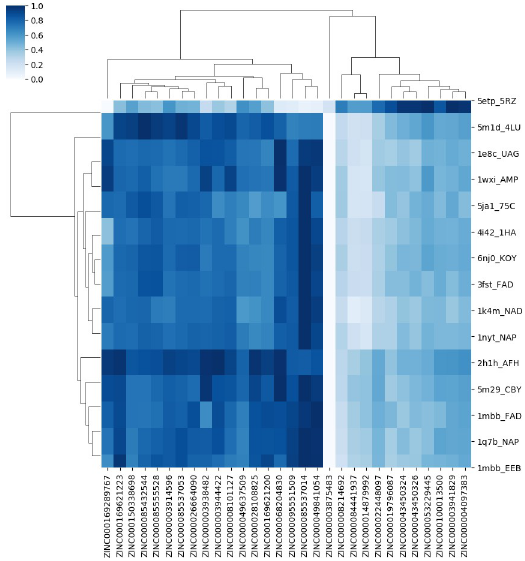
Fig 2. The heat map of selected ligands from the top five ranks of essential targets.